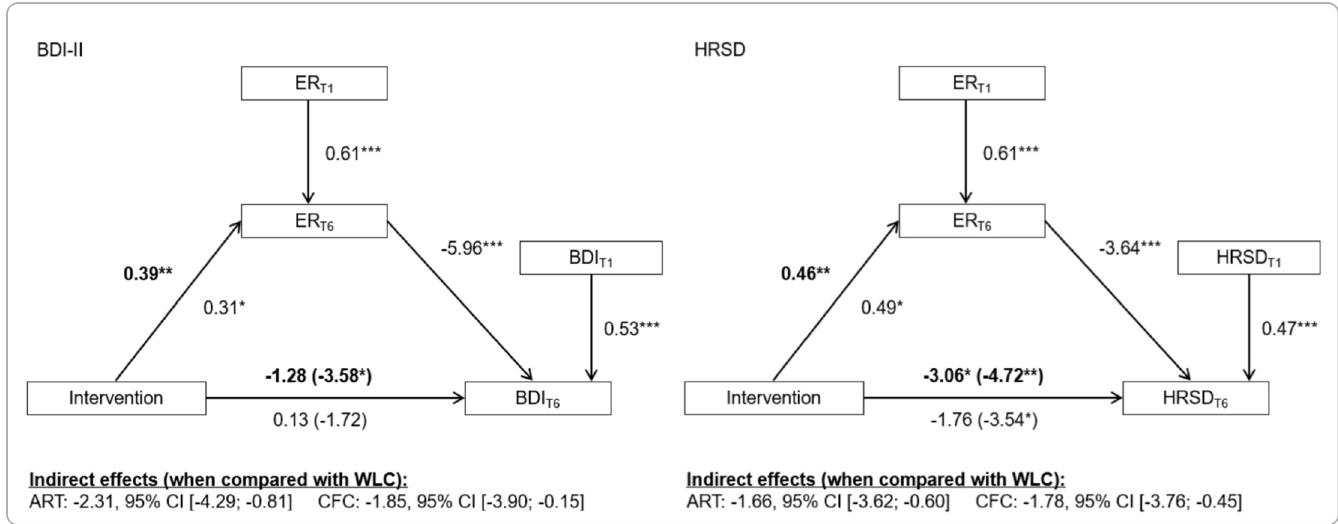
Fig 2. Affect regulation mediates the effects of both active treatments on depression. ER = emotion regulation; BDI-II = Beck Depression Inventory II; HRSD = Hamilton Rating Scale for Depression; � p < .05, �� p < .01, ��� p < .001.